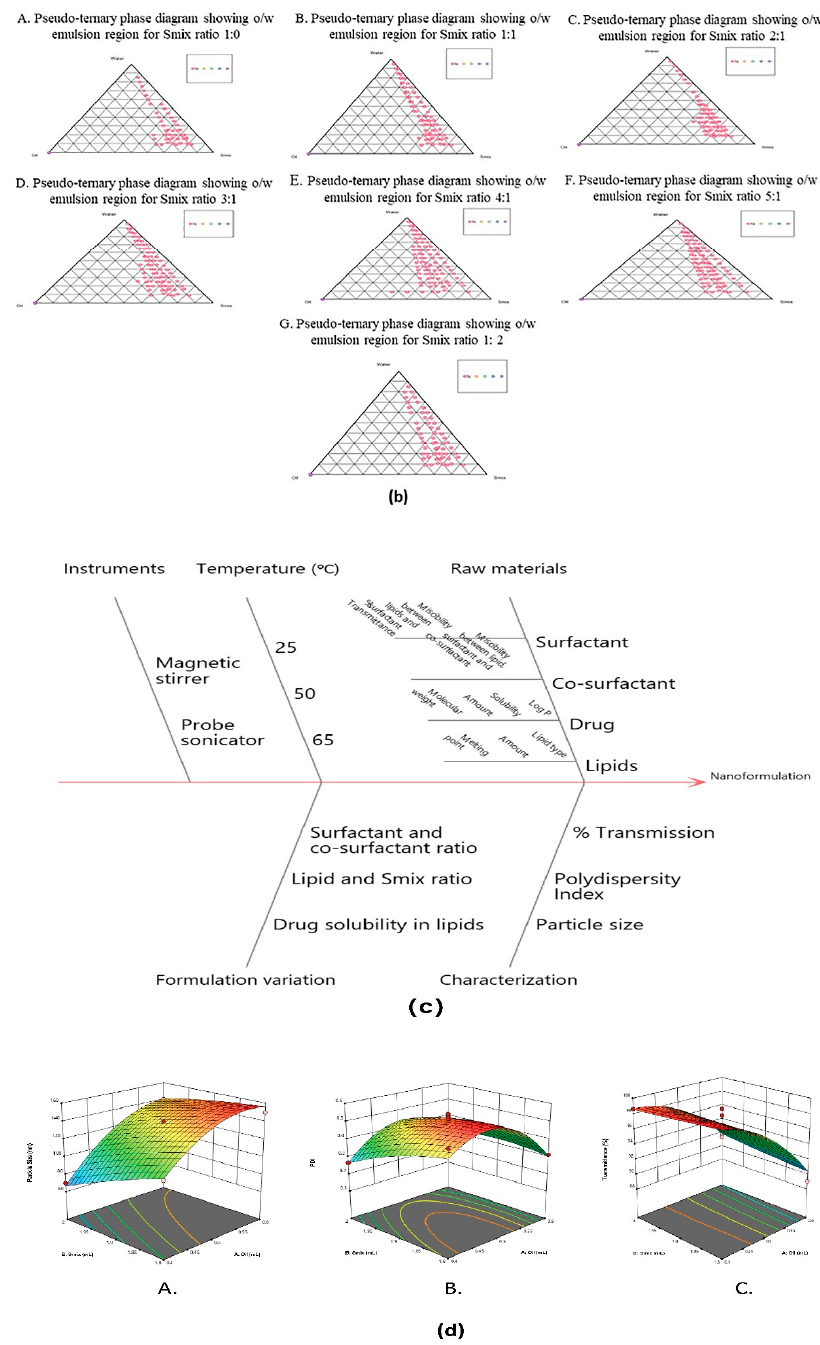
Figure 3. Representation of ( a ) solubility of TAM and RES in various lipids. Maximum solubility of both drugs was observed in capmul MCM EP. ( b ) Pseudo ternary phase diagram with different Smix ratios 1:0, 1:1, 2:1, 3:1, 4:1, 5:1, 1:2. ( c ) Ishikawa diagram for SNEDDS development. ( d ) 3D surface response plot showing effect of concentration of oil and S mix on the ( A ). Droplet size—Droplet size increased with an increase in the concentration of oil whereas, decreased with an increase in the concentration of S mix , ( B ). PDI—PDI decreased with an increase in the concentration of oil and increased with an increase in the concentration of S mix . However, combination of concentration of oil and S mix provided better homogeneity ( C ). % Transmittance—% Transmittance increased with decrease in the concentration of oil and increase in concentration of S mix . Data are given as mean ± standard deviation ( n = 3) with statistical difference at (***) p <